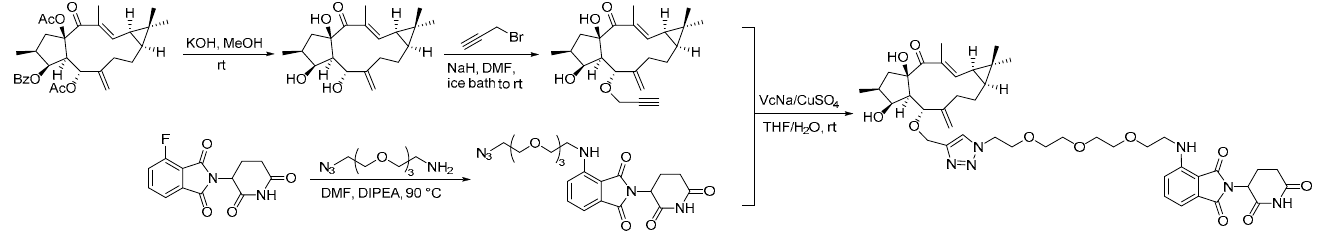
Scheme 12. Synthesis of the lathyrol-derivatized–based